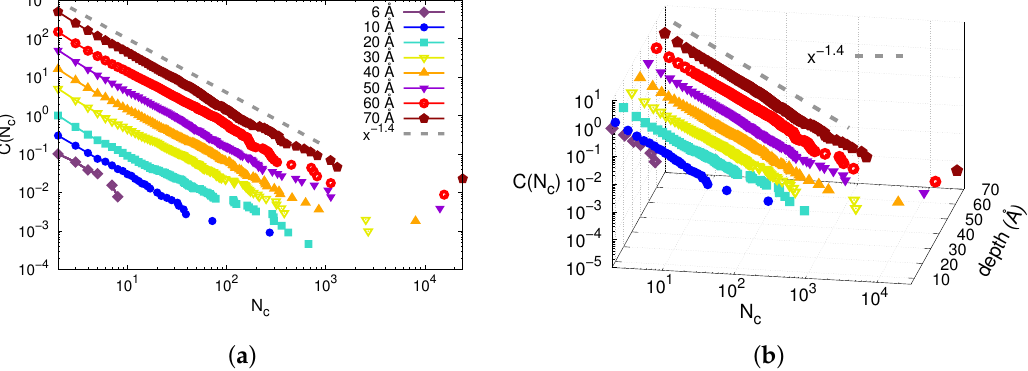
Figure 8. Complementary cumulative distributions C ( N c ) at different indentation depths at T = 10 K. ( a ) The curves are shifted in the y direction for better readability. ( b ) 3D plot which avoids shifting the curves. The gray dashed line corresponds to a power law with exponent −